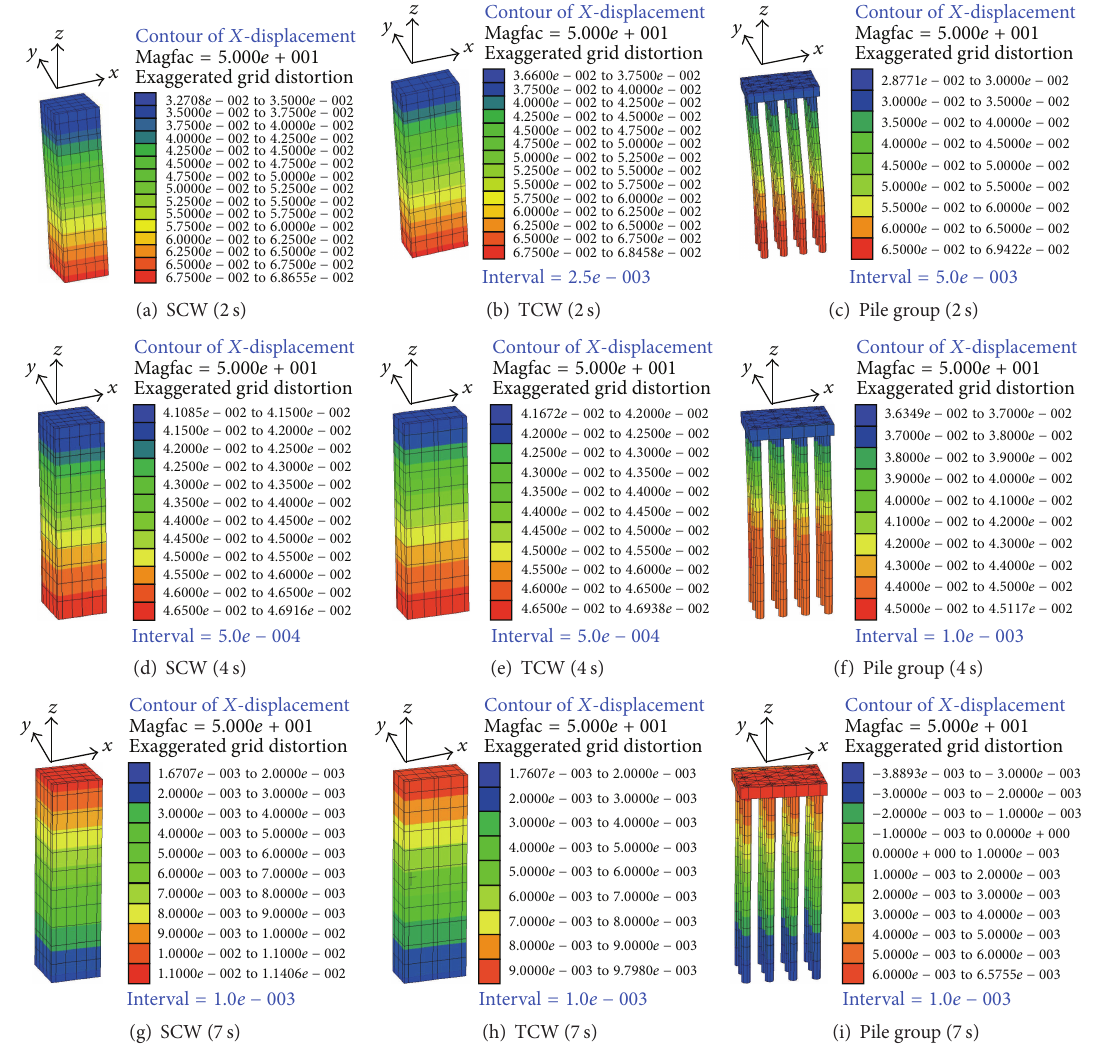
Figure 14: Deformation of wall/pile body at different seconds (magnification factor: 50